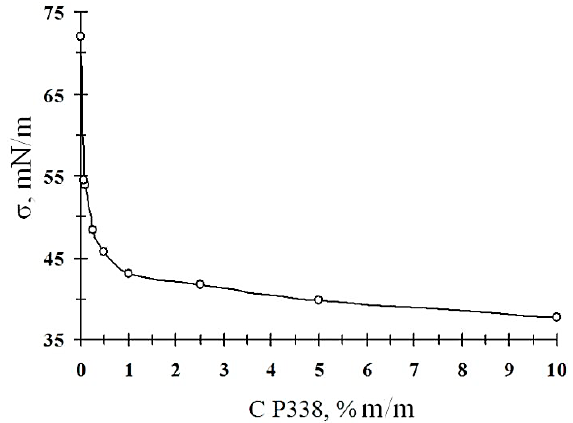
Fig. 12. Surface tension (σ) isotherms for P338 aqueous solutions at 25